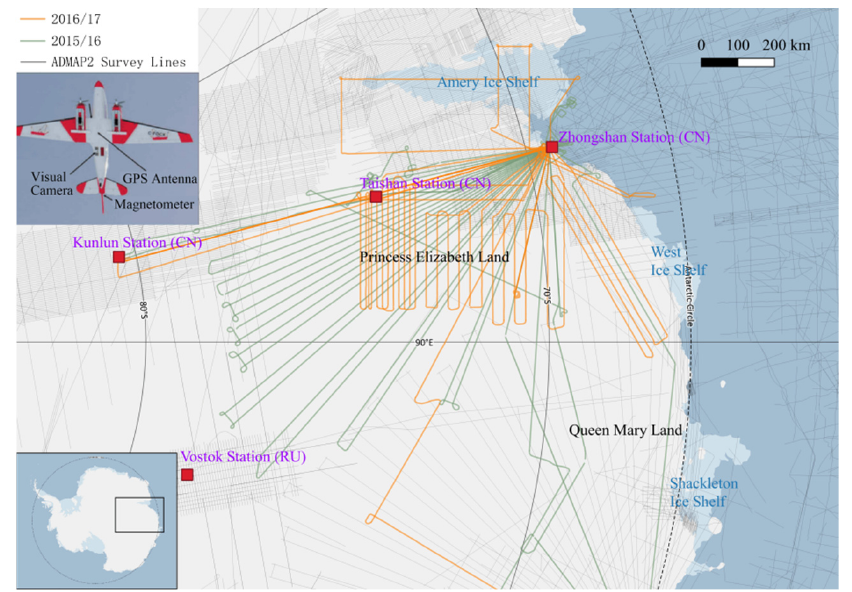
Figure 1. Snow Eagle 601 aeromagnetic survey lines. The CS-3 magnetometer was used to measure the magnetic field. It was installed on the tail of the aircraft to avoid magnetic interference from the metal fuselage. The